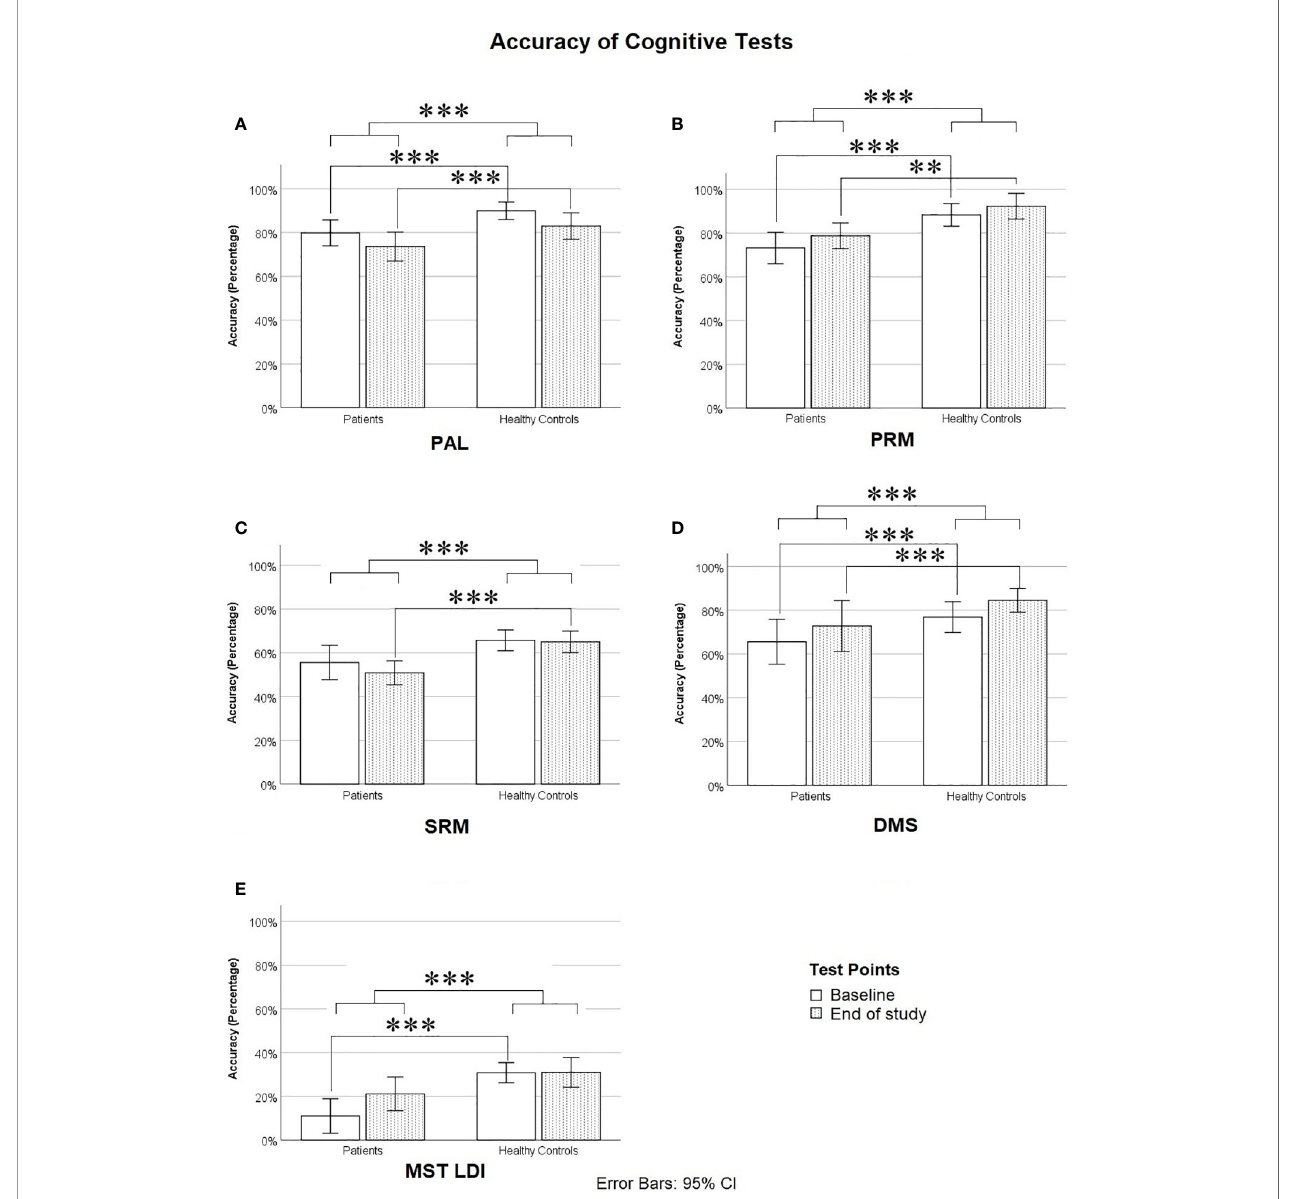
FIGURE 2 | Accuracy on cognitive tests: (A) Paired Associates Learning (PAL, Average of PAL-6 and PAL-8), (B) Pattern Recognition Memory (PRM), (C) Spatial Recognition Memory (SRM), (D) Delayed Match to Sample task (DMS, Level 4), and (E) Mnemonic Similarity Test Lure Discrimination Index (the proportion of lures correctly called “ Similar ” minus the proportion of novel foils incorrectly called “ Similar ” ). *** means p ≤ 0.001. TABLE 4 | MST difference scores for patients in Low and High improvement groups.